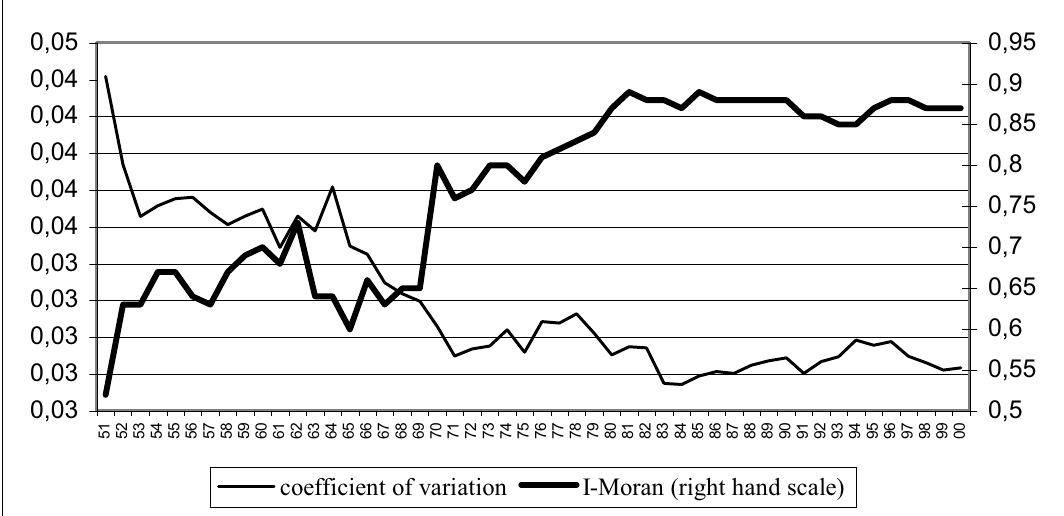
Figura 1 – Italian Provinces Convergence of Per-capita Income and Related Spatial Autocorrelation in the Period